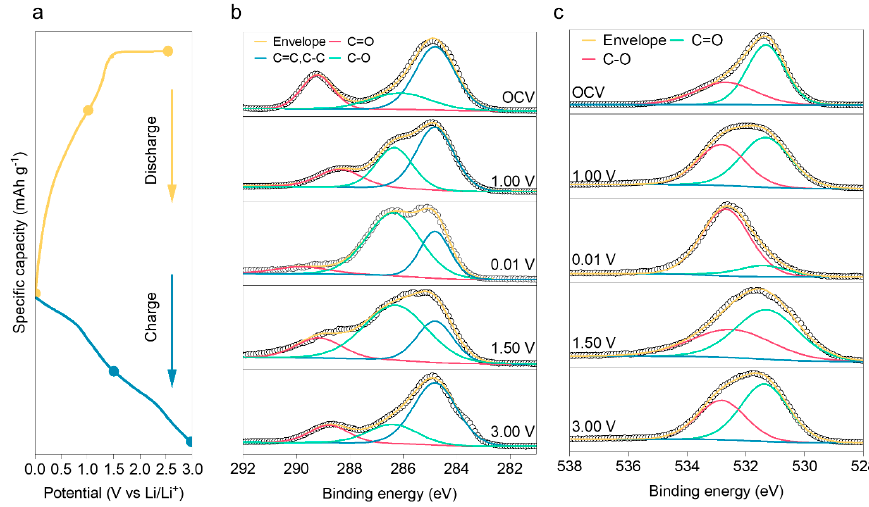
Figure 3. ( a ) The selected points for XPS measurements at various electrochemical states. XPS spectra of ( b ) C 1s and ( c ) O 1s of TP − Ni electrodes at different discharge/charge states.